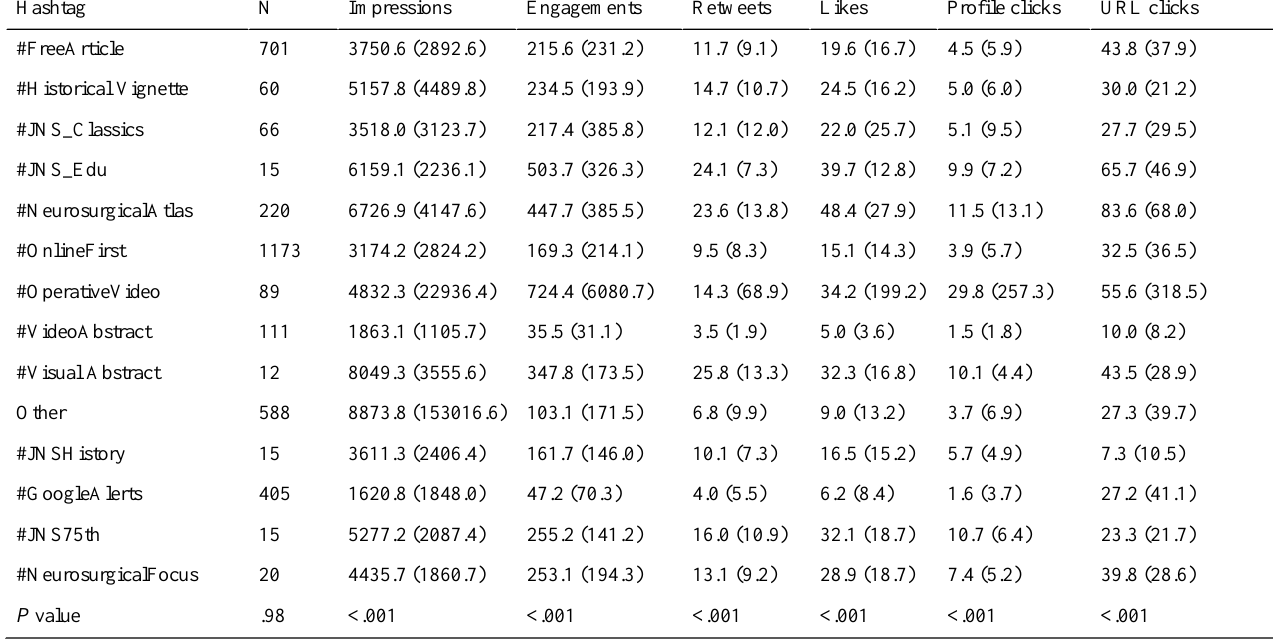
Table 2. Twitter analytics, mean (SD) per tweet, by